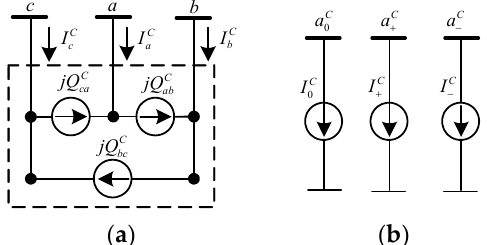
Figure 4. Main circuit structure and corresponding sequence circuit models of the proposed compensator. ( a ) Main circuit structure in the a , b , c frame; ( b ) sequence circuit models in the 0, +, − frame.